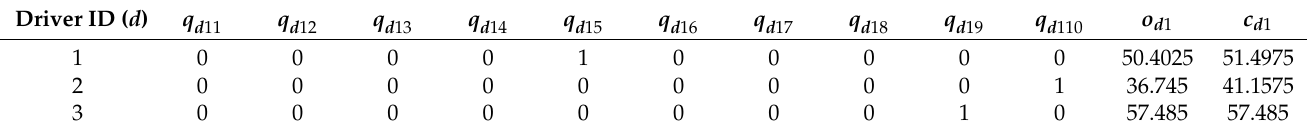
Table 8. Bid submitted by Driver 1.